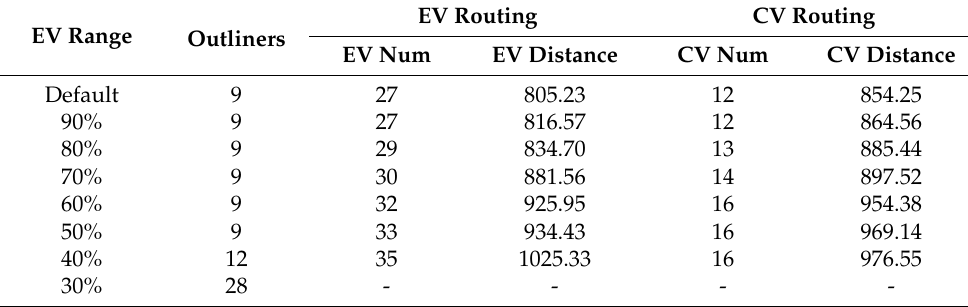
Table 7. Results for instance c101_21 with different ranges of